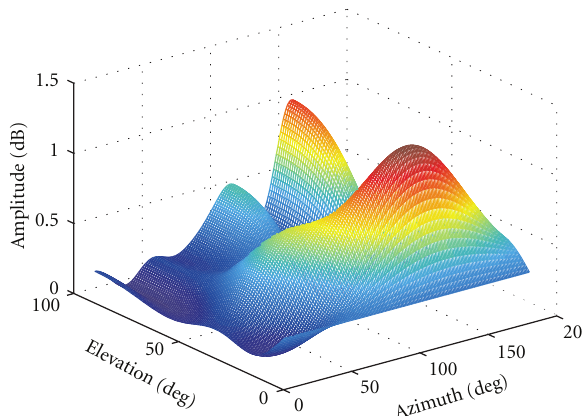
Figure 6: MUSIC pseudospectrum when mutual coupling is uncompensated.